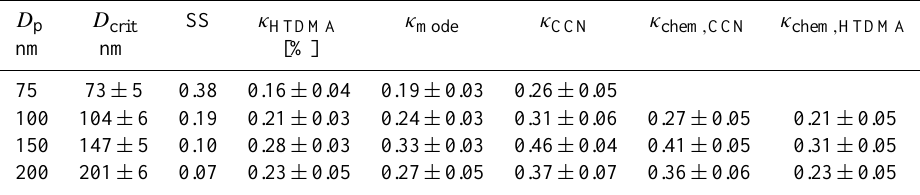
Table 3. Overview of the HTDMA-derived and CCN-derived hygroscopicity parameters κ . D p D crit SS κ HTDMA κ mode κ CCN κ chem , CCN κ chem , HTDMA nm nm